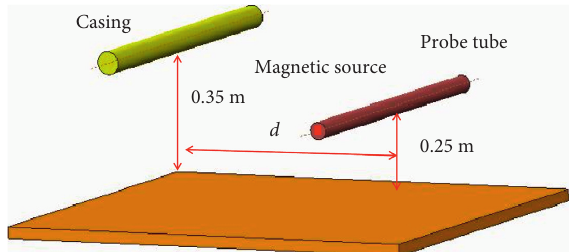
Figure 8: Position relationship between the probe and the